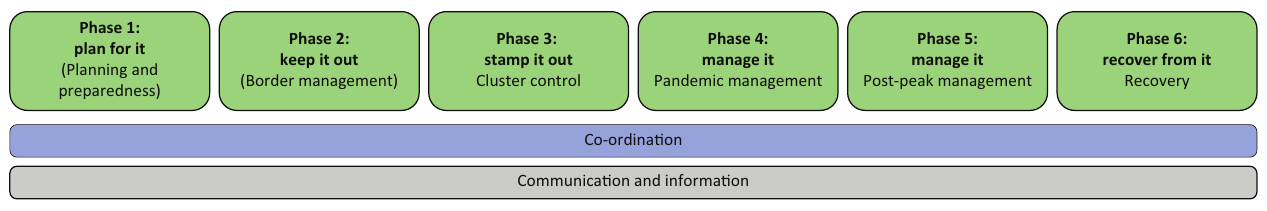
FIG URE 2: Pandemic response phases and interventions as per the Influenza Pandemic